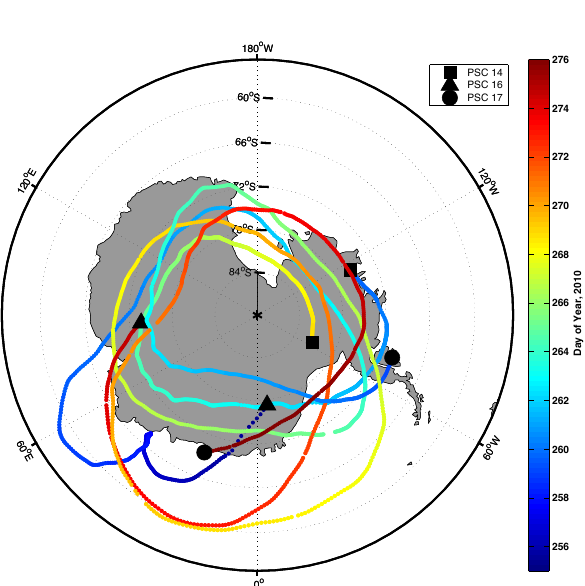
Figure 1. The flight paths of the three ozone Concordiasi balloons are